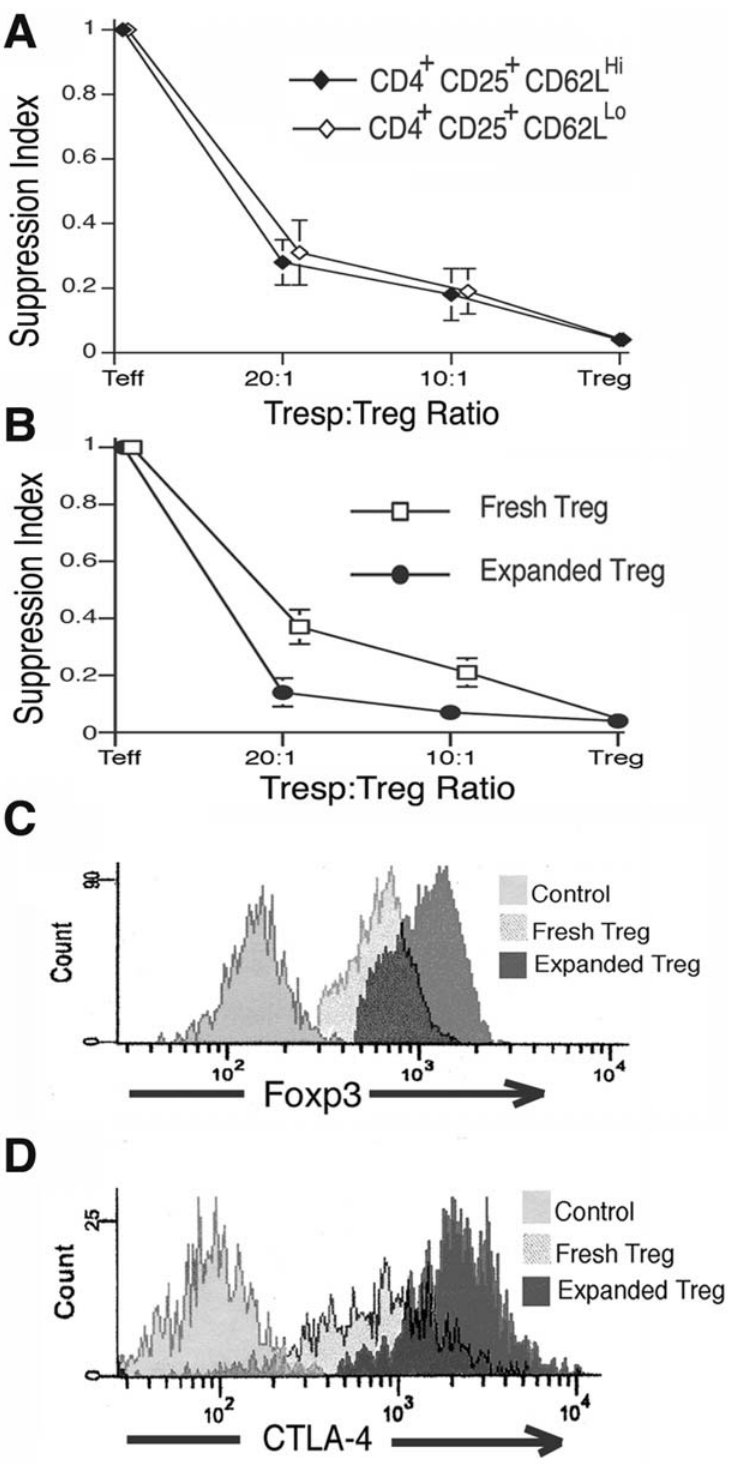
Figure 2. CD4 + CD25 + T reg function and phenotype is enhanced by exogenous expansion. A) Freshly isolated CD62L HI and CD62L LO fractions of CD4 + CD25 + T regs demonstrate equivalent suppression capacity in vitro as measured by mixed lymphocyte suppression assay (p $ 0.25 for each cell ratio, 3–6 mice per group). The Suppression Index measures the capacity of T regs to suppress T resp proliferation (as measured by decreased tritium-labeled thymidine incorporation) at different T resp :T reg ratios divided by the maximal T resp proliferation in the absence of T regs B) Ex vivo expansion of CD4 + CD25 + T regs significantly enhances the ability of these cells to suppress proliferation of T resp cells derived from 29-week-old B/W mice (p # 0.04 for each cell ratio, 6 mice per group). C–D) Foxp3 + and CTLA-4 (surface and intracellular) expression in exogenously expanded T regs were significantly greater than in freshly isolated T regs as measured by mean-fluorescent intensity (p=0.007, p , 0.001 respectively, 3–6 mice per group).